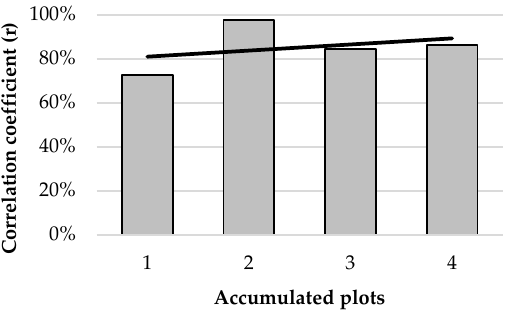
Figure 14. Correlation coefficient between the number of droppings and the number of location fixes per accumulated plot.